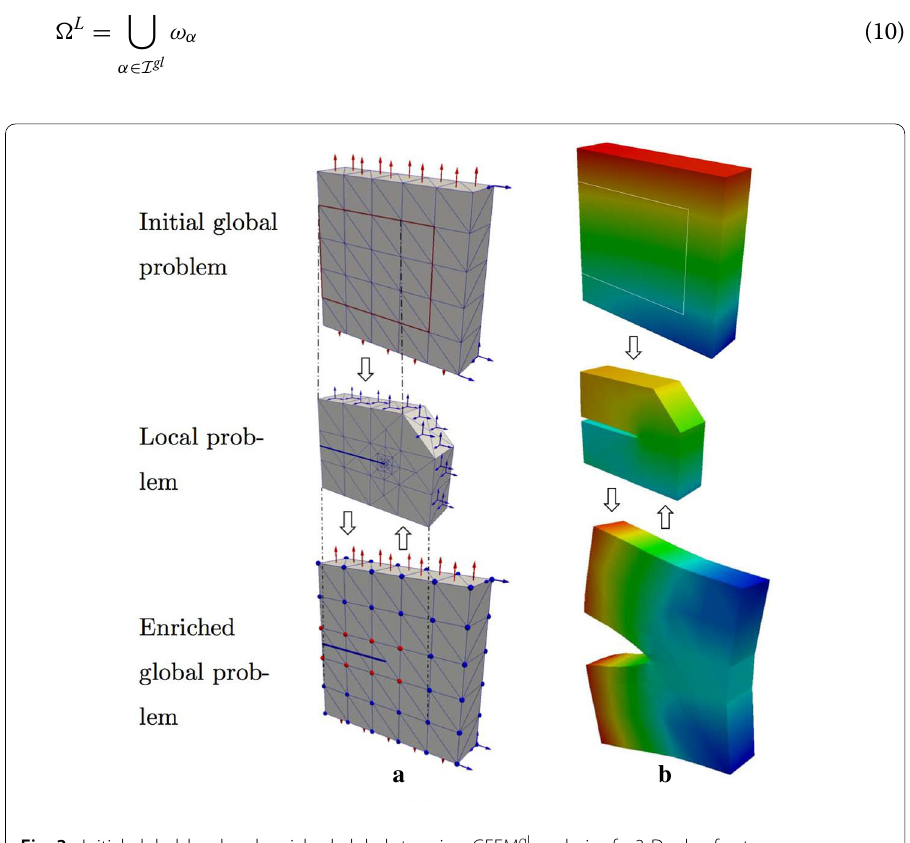
Fig. 3 Initial global, local and enriched global steps in a GFEM gl analysis of a 3-D edge fracture— a disretizations for the initial global, local and enriched global problems— b initial global, local and enriched global solutions. This figure presents the global–local iterations between enriched global and local problems. The block arrows between problems represent exchange of